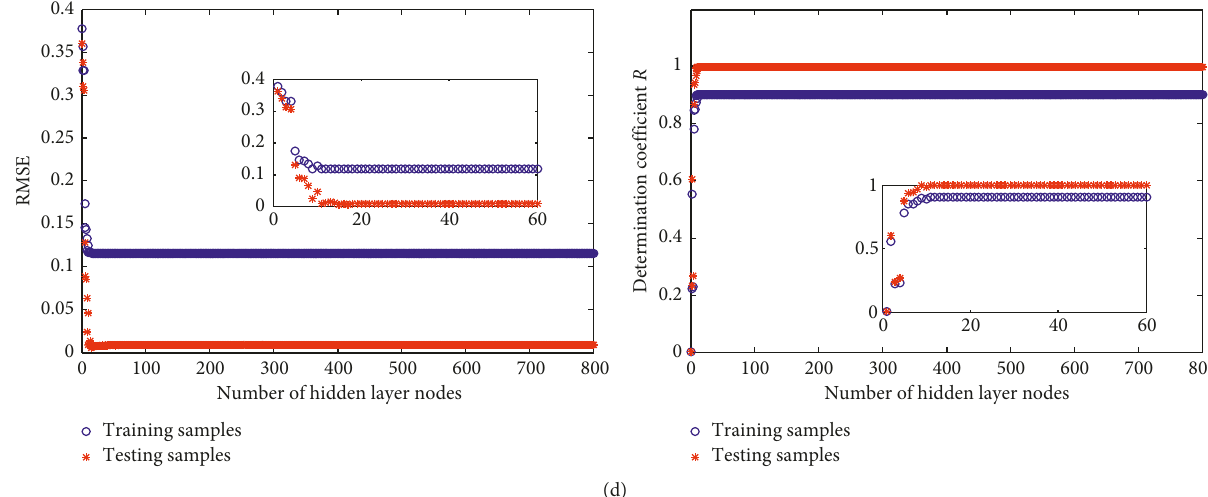
Figure 1: ELM training and testing results of the selected UCI regression data sets: (a) spectra; (b) concrete; (c) fertility; (d) sinc